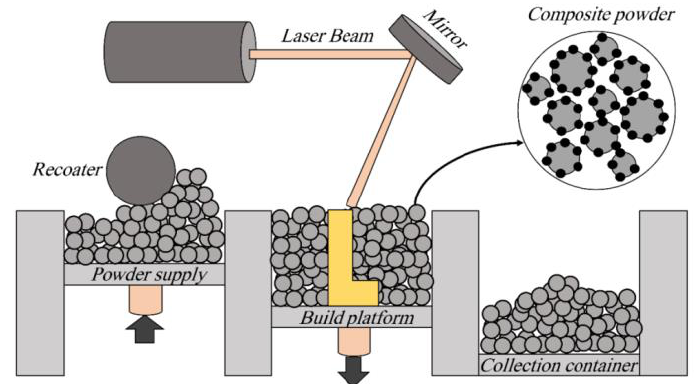
Figure 2. Schematic view illustrating the fabrication of composite parts by the SLM process.